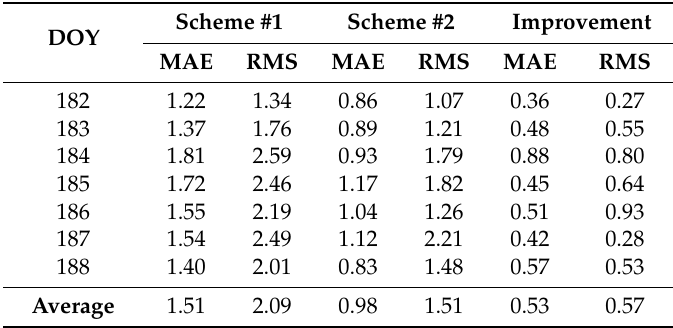
Table 6. Statistical results of the water vapor density profile comparison between radiosonde and different schemes at UTC 12:00 from DOY 182 to 188, 2017.